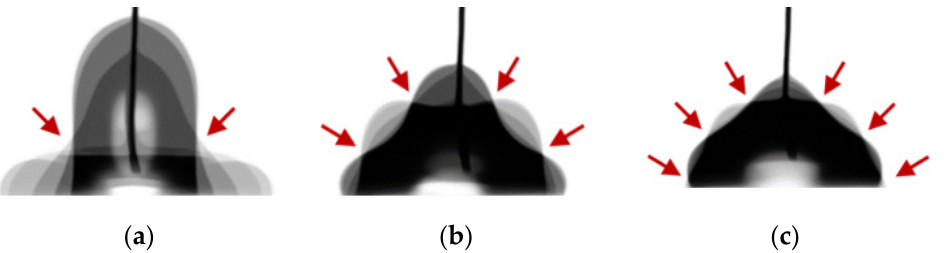
Figure 5. Frequency-dependent oscillation patterns of a water drop. Low-frequency AC electro- wetting performance was studied with a 15 μ L water drop placed on an ITO-coated glass sub- strate covered with 8.3 μ m ion gel and 150 nm hydrophobic layers, respectively. An AC input voltage keeps constant at V RMS = 26.5 V, while the applied AC frequency ( f ) was varied. At a low- frequency range, the droplet mainly undergoes its oscillation whose shape relies on f . The oscilla- tion amplitude is noticeably enlarged at corresponding resonance frequencies of ( a ) f 1 = 25 Hz, ( b ) f 2 = 75 Hz, and ( c ) f 3 = 120 Hz, and shows a decreasing trend with the resonance frequency. The arrows indicate the oscillation node points. To quantify the low-frequency AC electrowetting performance with the ion gel, the oscillation amplitude of the droplet was characterized by normalizing the droplet size ra- dially elongated by the Maxwell stress to the original base diameter of 3.25 mm. Figure 6 presents the normalized oscillation magnitude at each resonance mode. On the gel layer,